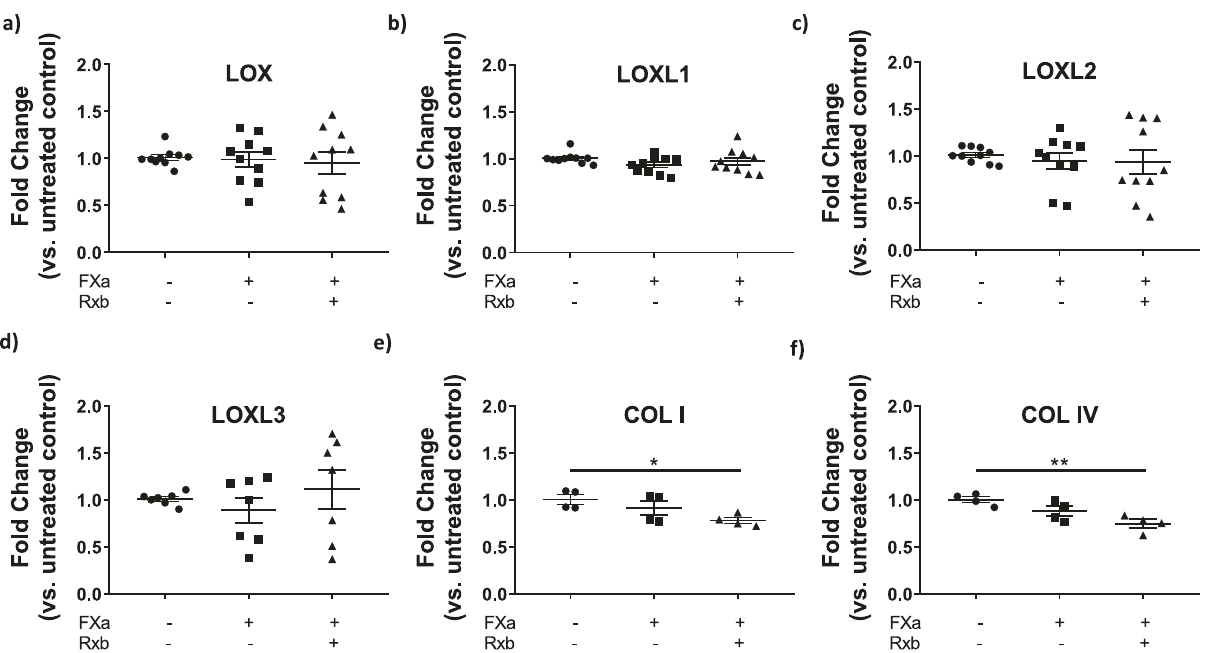
Fig. 3 FXa does not alter gene expression of the LOX family. Gene transcription analysis by qPCR of a LOX , b LOXL1 , c LOXL2 , d LOXL3 , e COLI , and f COLIV . Data are shown as fold-change in gene expression in A7r5 cells with or without 24 h of FXa (1 μ g/ml) and rivaroxaban (Rxb, 100 nM) incubation, vs. average gene expression of untreated control A7r5s ( n = 10 for LOX, LOXL1, and LOXL2 , n = 7 for LOXL3 , n = 4 for COLI and COLIV ; * P < 0.05, ** P < 0.01, by one-way